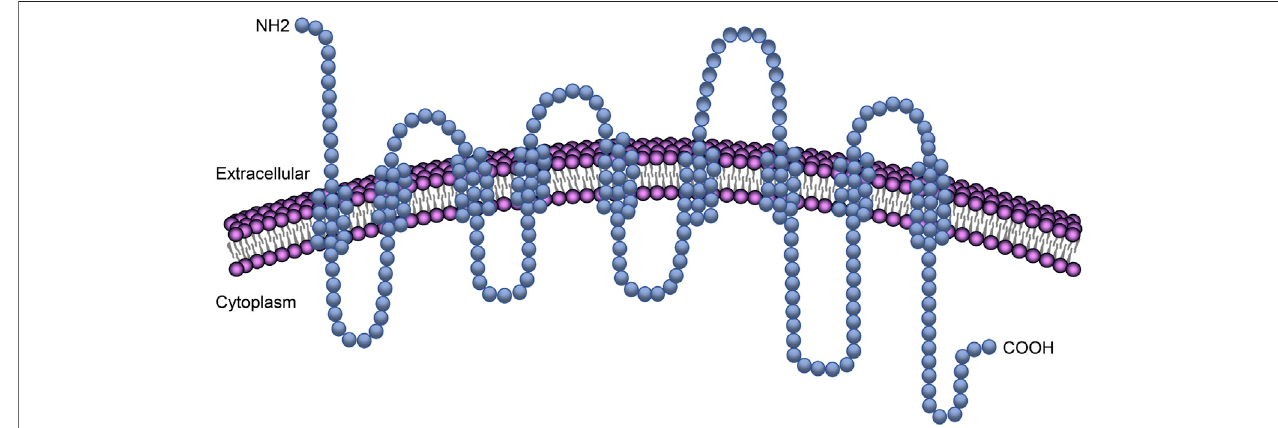
FIGURE 1 | NTCP transmembrane domains in the plasma membrane. The transmembrane protein NTCP has a putative nine transmembrane domains with a topology predicted to consist of an extracellular N-terminus and an intracellular